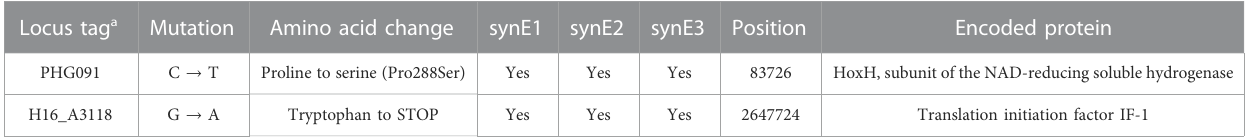
TABLE 7 Mutations found in isolates synE1, synE2 and synE3. Locus tag